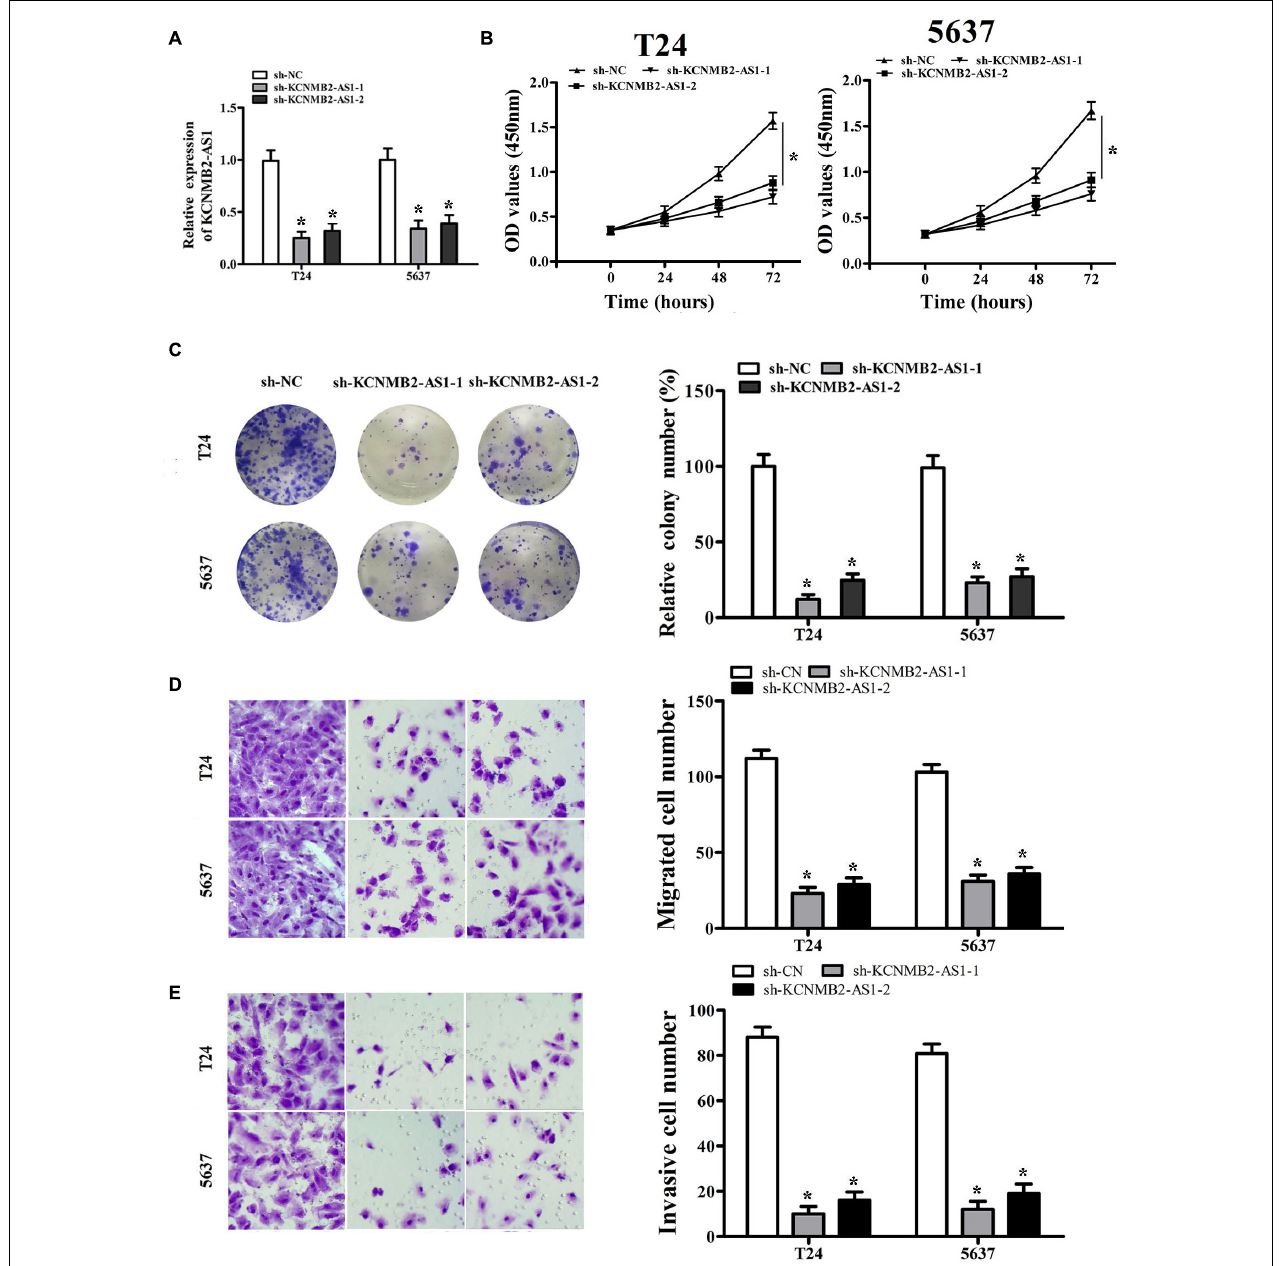
FIGURE 2 | KCNMB2-AS1 promoted BC cell proliferation, migration, and invasion. (A) The efficiency of KCNMB2-AS1 knockdown was detected by qRT-PCR. (B,C) Cell proliferation was assessed in T24 and 5,637 cells by CCK8 assay and colony formation assay. (D,E) Transwell migration and invasion assays were performed after KCNMB2-AS1 knockdown. Data were shown as mean ± standard deviation. The experiment was repeated three times. * P <